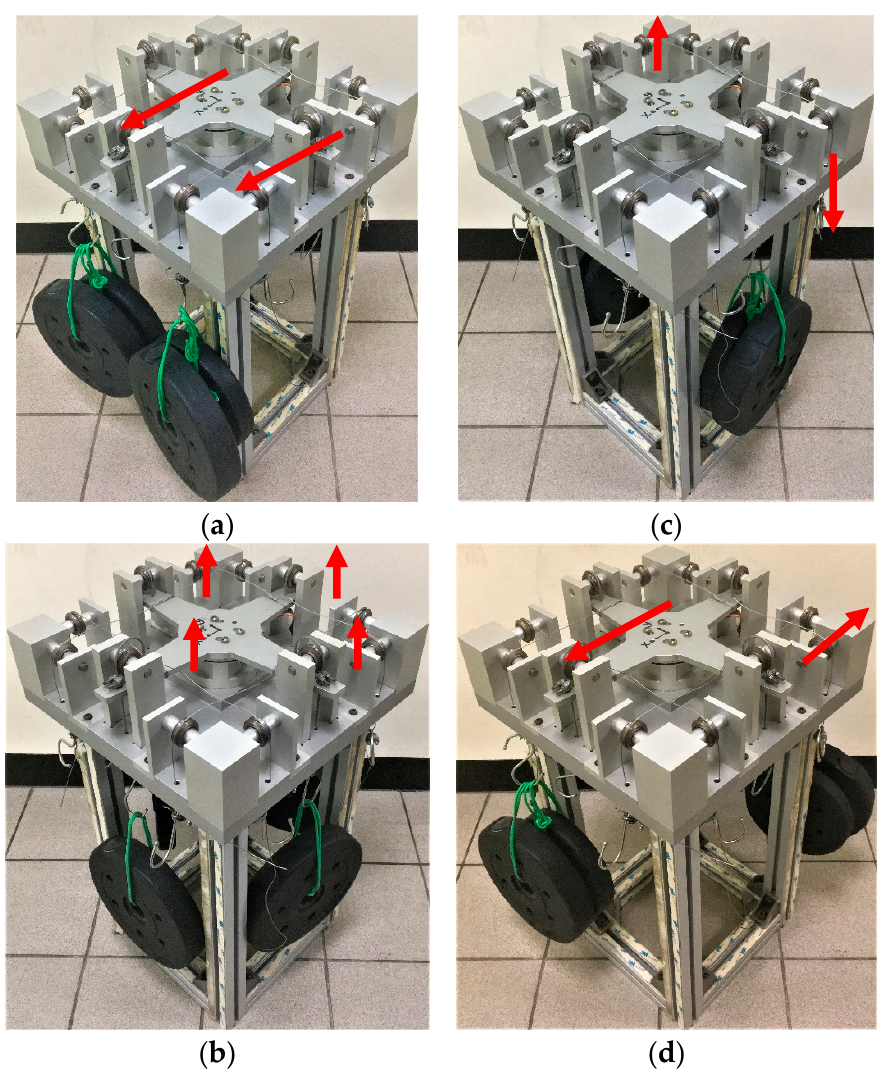
Figure 14. Schematic of the applied loading conditions on the jig: ( a ) F x or F y , ( b ) F z , ( c ) M x or M y , and ( d ) M z [23] .